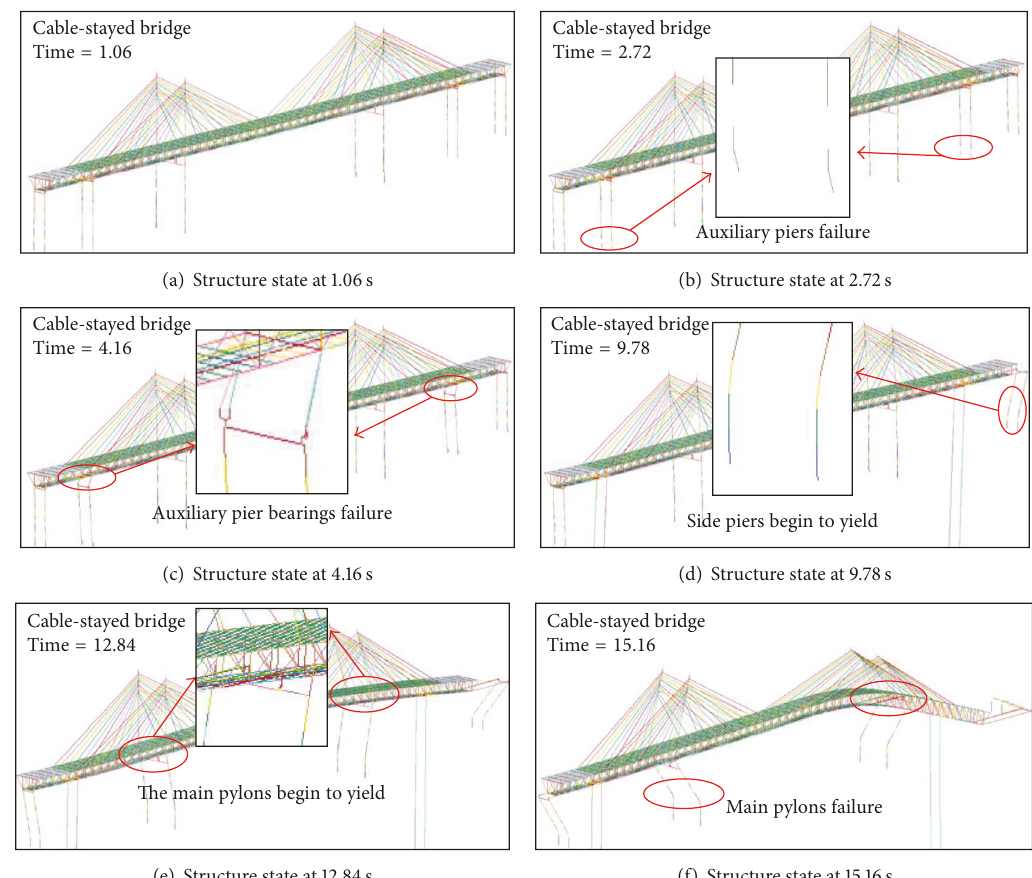
Figure 12: Collapse failure process under RSN6-H2 seismic